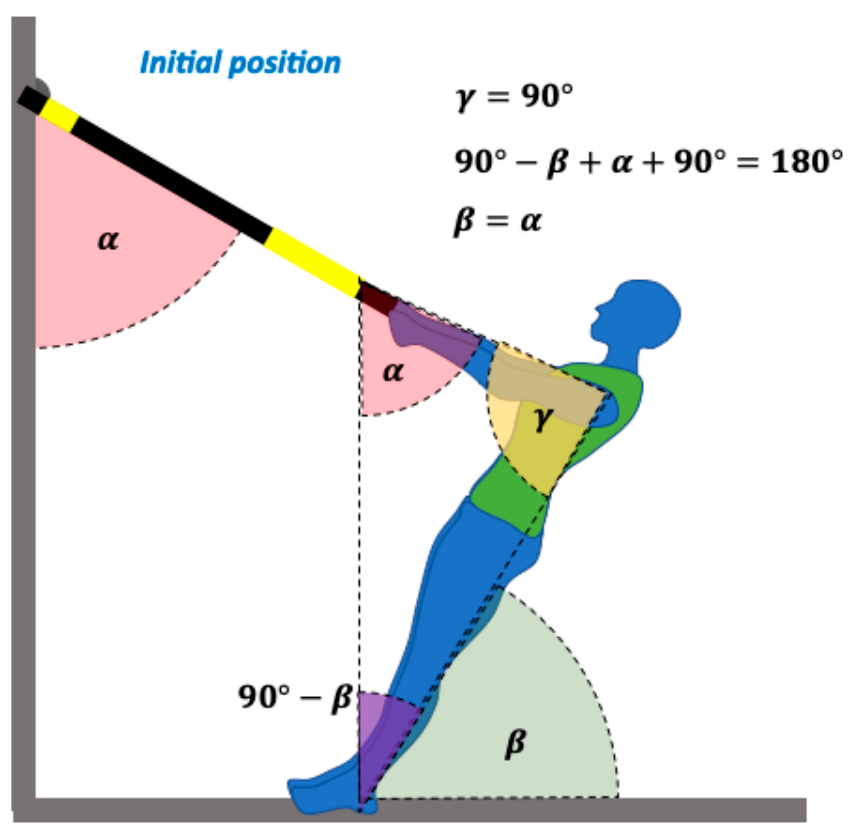
Figure 2. Representation of the forces involved in the